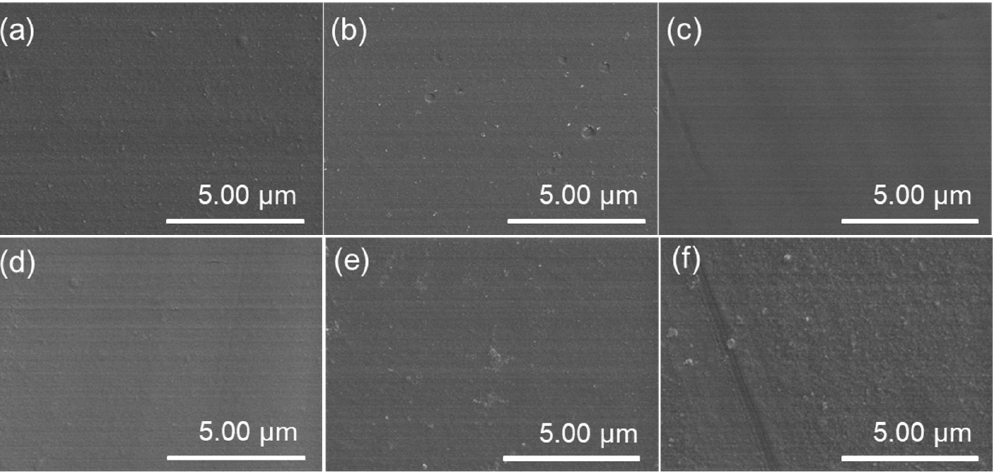
Figure 3. Surface morphologies of the PIMs with different content of carrier: ( a ) 20%; ( b ) 30%; ( c ) 40%; ( d ) 50%; ( e ) 60%; and ( f ) 70%.